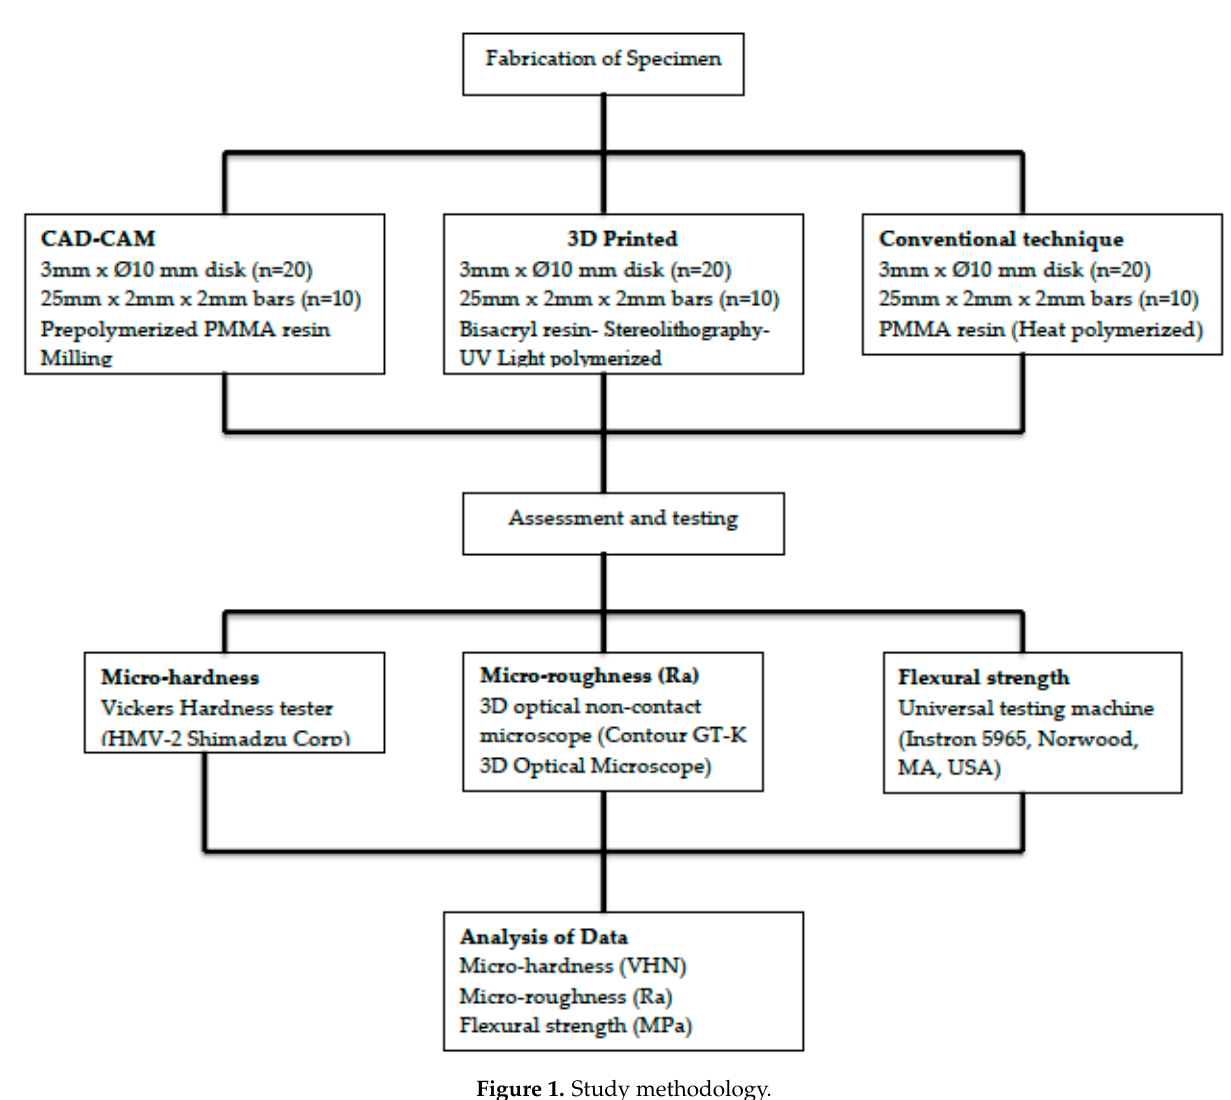
Figure 1. Study Figure 1. Study methodology.